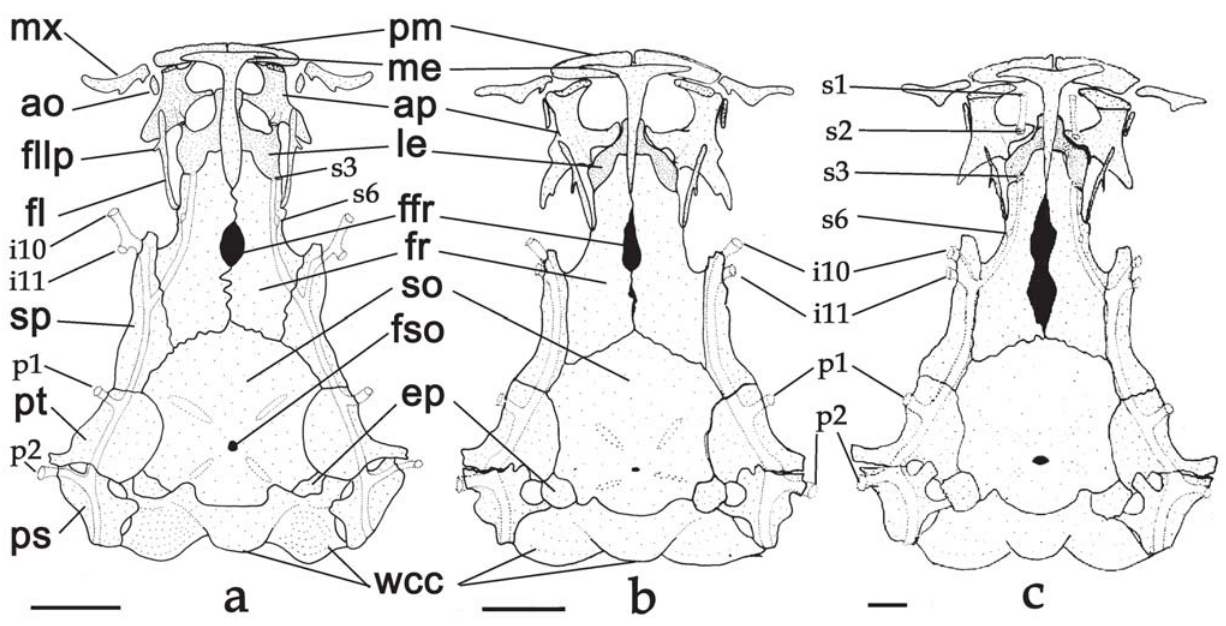
Fig. 2. Neurocranium and Weberian apparatus of: a. Ituglanis cahyensis , MNRJ 28405, paratype, 41.3 mm SL. b. Ituglanis parahybae , MNRJ 15413, 35.4 mm SL. c. Ituglanis proops MNRJ 13597, 60.5 mm SL. Dorsal view. Abbreviations: ao, antorbital; ap, autopalatine; ep, epioccipital; fr, frontal; ffr, frontal fontanel; fl, fronto-lacrimal tendon bone; fllp, fronto-lacrimal lateral process; fso, parieto-supraoccipital fontanel; i10, i11, infraorbital sensory pores 10 to 11; le, lateral ethmoid; me, mesethmoid; mx, maxilla; pm, premaxilla; ps, posttemporosupracleitrum; pt, pterotic; p1, p2, postotic sensory pores 1 to 2; so, parieto-supraoccipi- tal; sp, sphenotic; s1, s2, s3, s6, supraorbital sensory pores 1 to 6; wcc, weberian complex and capsule. Scale bar = 1.0